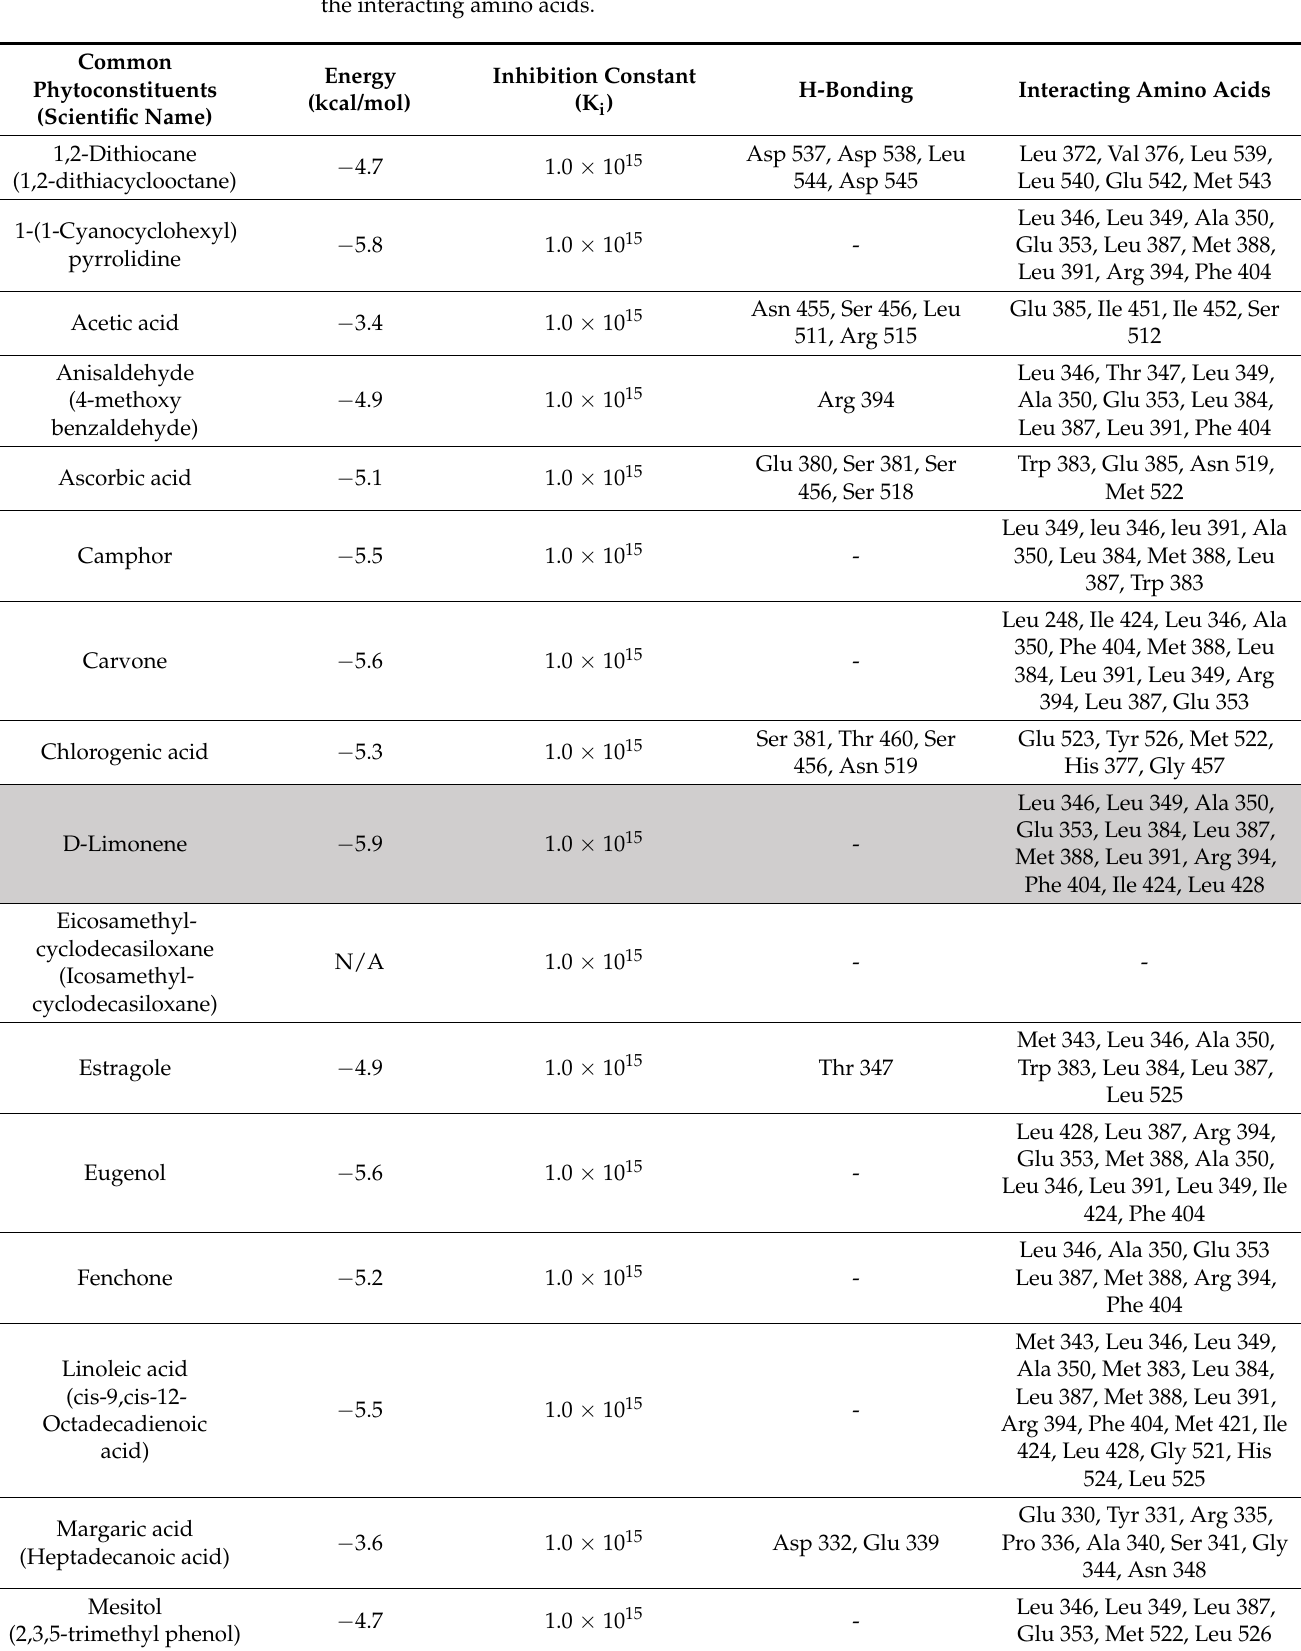
Table 2. Binding energies of important Foeniculum vulgare constituents with breast cancer target and the interacting amino